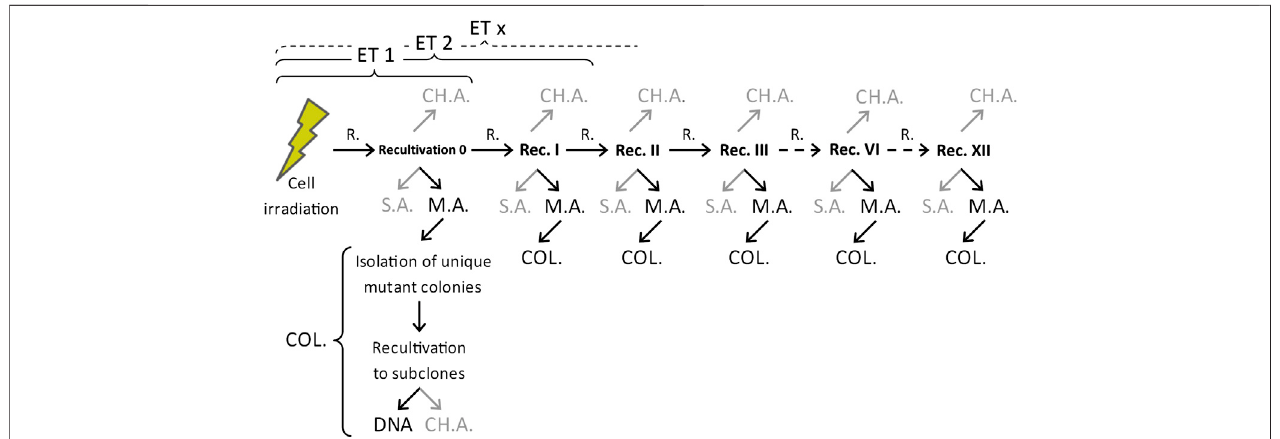
FIGURE 1 | Scheme of the general experimental procedure after irradiation. In gray – methods and assays not directly covered by this work. R, recultivation; ET, expression time;M.A.,mutationassay(6-thioguanine); S.A., survivalassay; COL, isolationofindividual mutant colonies+ cellmultiplication for useinother assays;DNA, analysis of DNA (isolation, concentration measurements, PCR ampli fi cations, gel electrophoresis analysis, and evaluation); CH.A, chromosome aberration assay.